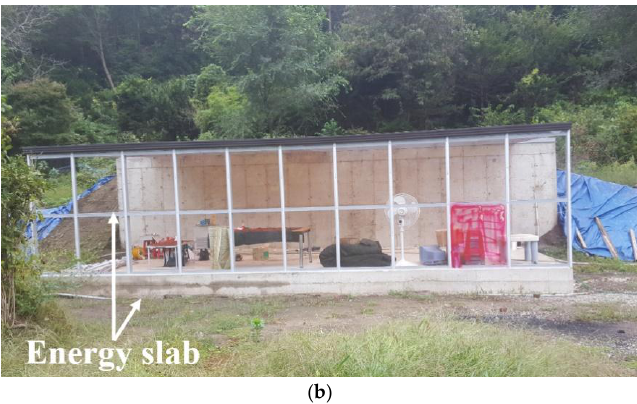
Figure 6. Views of constructed energy slab. ( a ) Side view of energy slab; ( b ) Front view of energy slab.